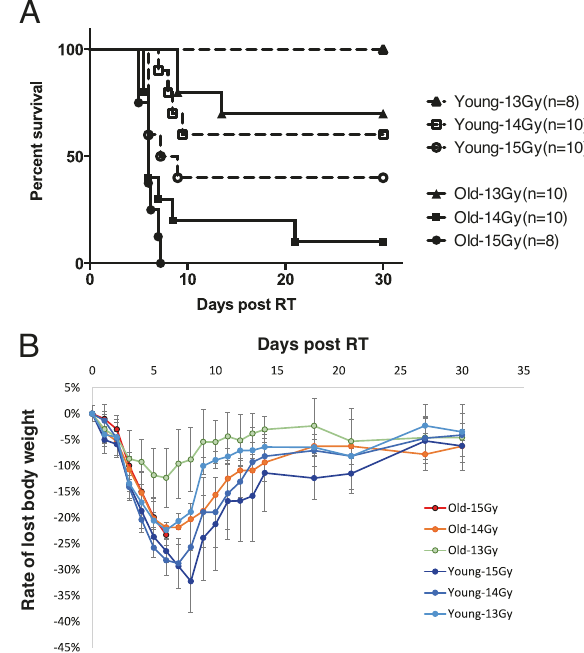
Fig. 1 Survival curves of 3 months young mice (Y) and 29 months old mice (O) post subtotal irradiation of 13 Gy, 14 Gy, and 15 Gy. A Percent of the survival curve. Numbers in parentheses indicate animal number/group. B Rate of lost body weight